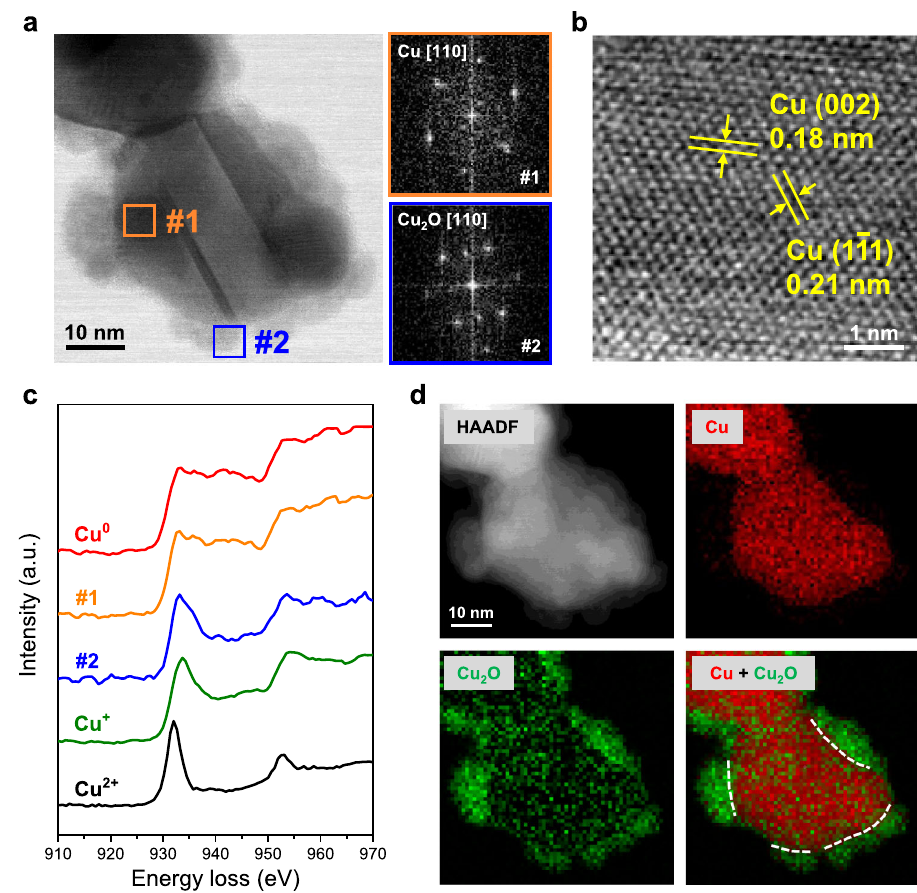
Fig. 3 STEM and EELS characterizations of the DVL-Cu catalyst. a STEM BF image (left) of DVL-Cu and FFT patterns (right) of the corresponding area in the BF image. b Enlarged image of area #1 in ( a ). c EELS spectra acquired from areas #1 and #2 in ( a ). Standard Cu, Cu + and Cu 2 + EELS results are plotted as references. d STEM high-angle annular dark- fi eld (HAADF) image and EELS maps of Cu and Cu 2 O and their overlay in DVL-Cu. The dashed lines highlighted in the overlay denote the Cu/Cu 2 O